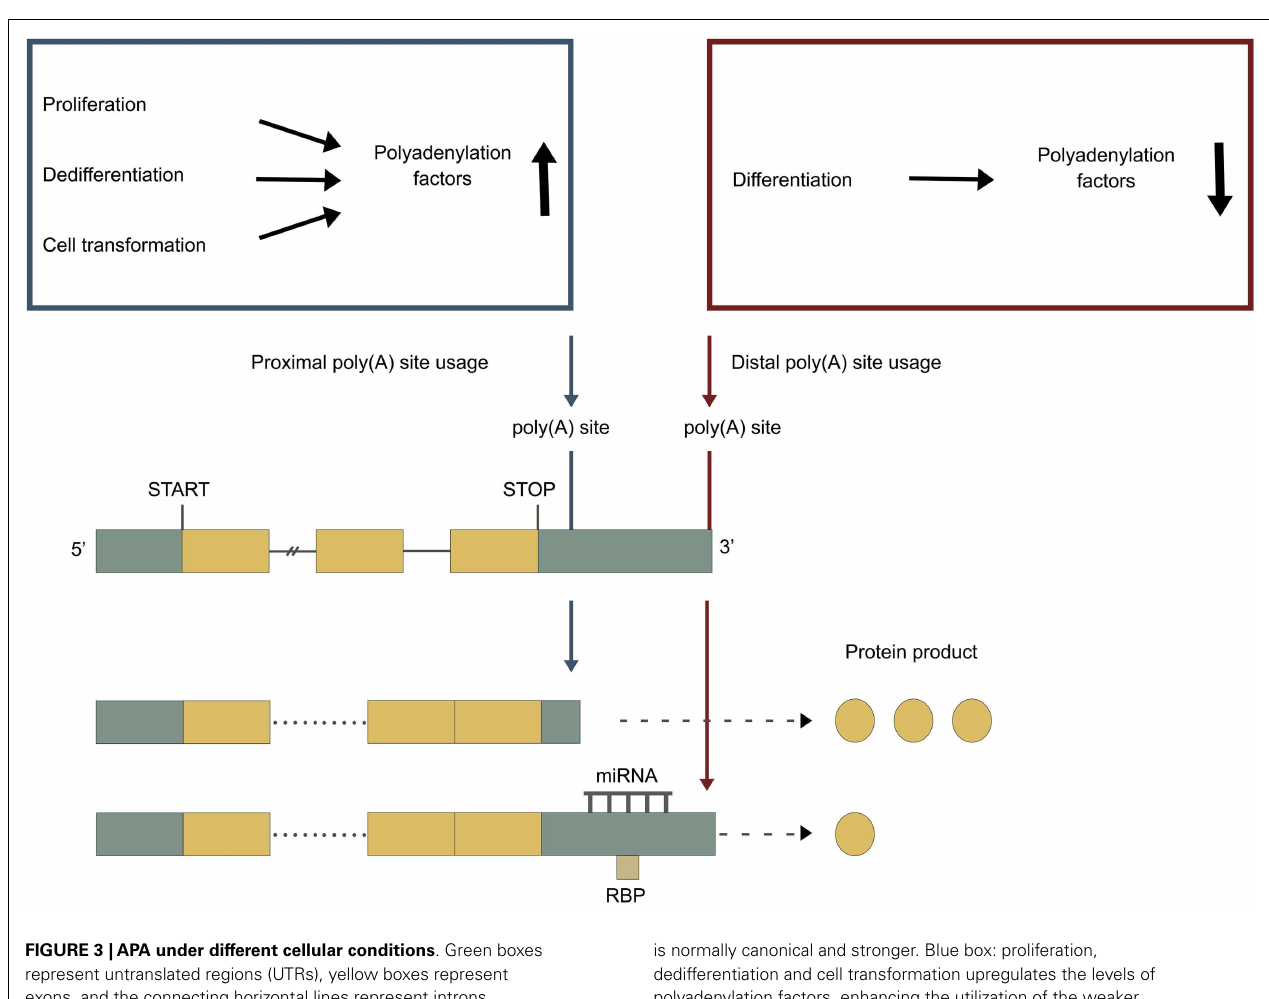
FIGURE 3 |APA under different cellular conditions . Green boxes represent untranslated regions (UTRs), yellow boxes represent exons, and the connecting horizontal lines represent introns. Adapted from Di Giammartino et al. (2011). Blue poly(A) site represents a proximal poly(A) site, which is normally non-canonical and weaker. Red poly(A) site represents a distal poly(A) site, which